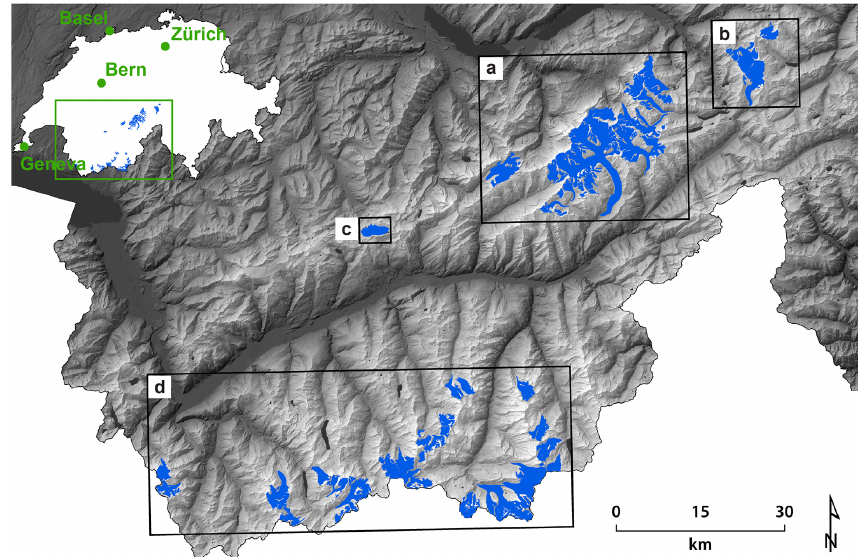
Figure 1. Overview of studied glaciers located in the western and southern Swiss Alps. The black frames mark the extent of detailed figures. The inset indicates the position of the study site in